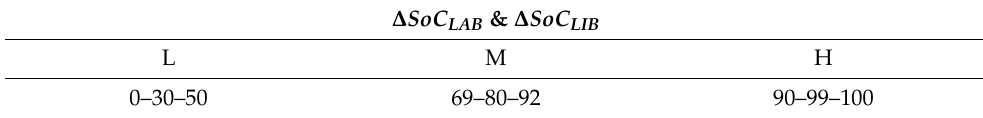
Table 3. The input membership functions for the ∆ SoC